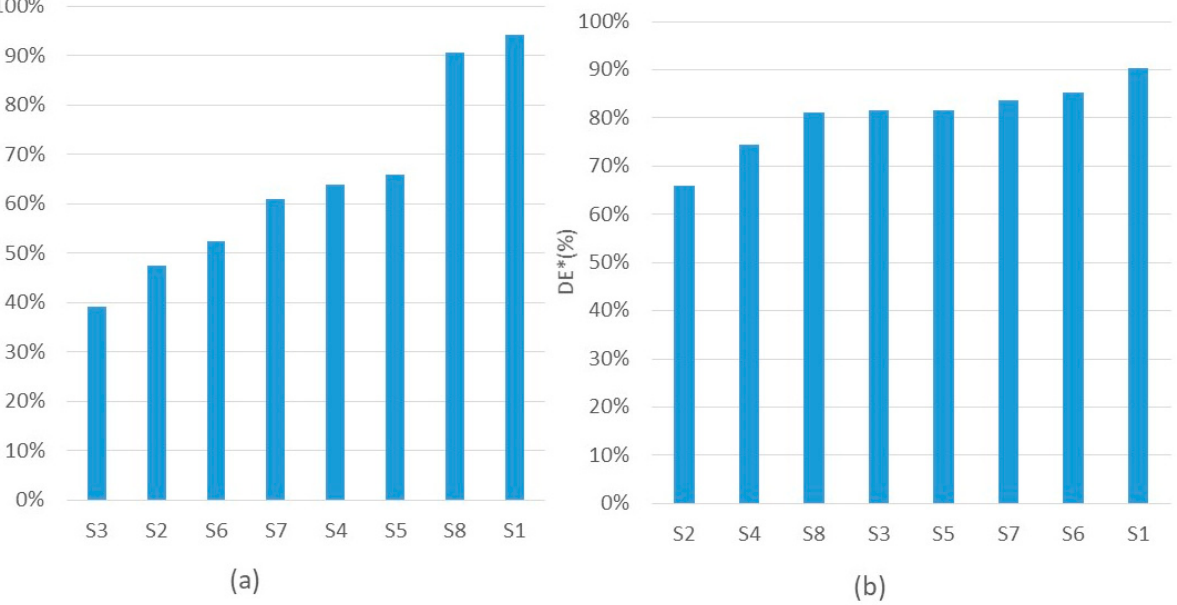
The six samples from the scaled-up experiment after extrusion are shown in Figure 5. The CIELAB values of each sample after extrusion and the DE* values are presented in Figure